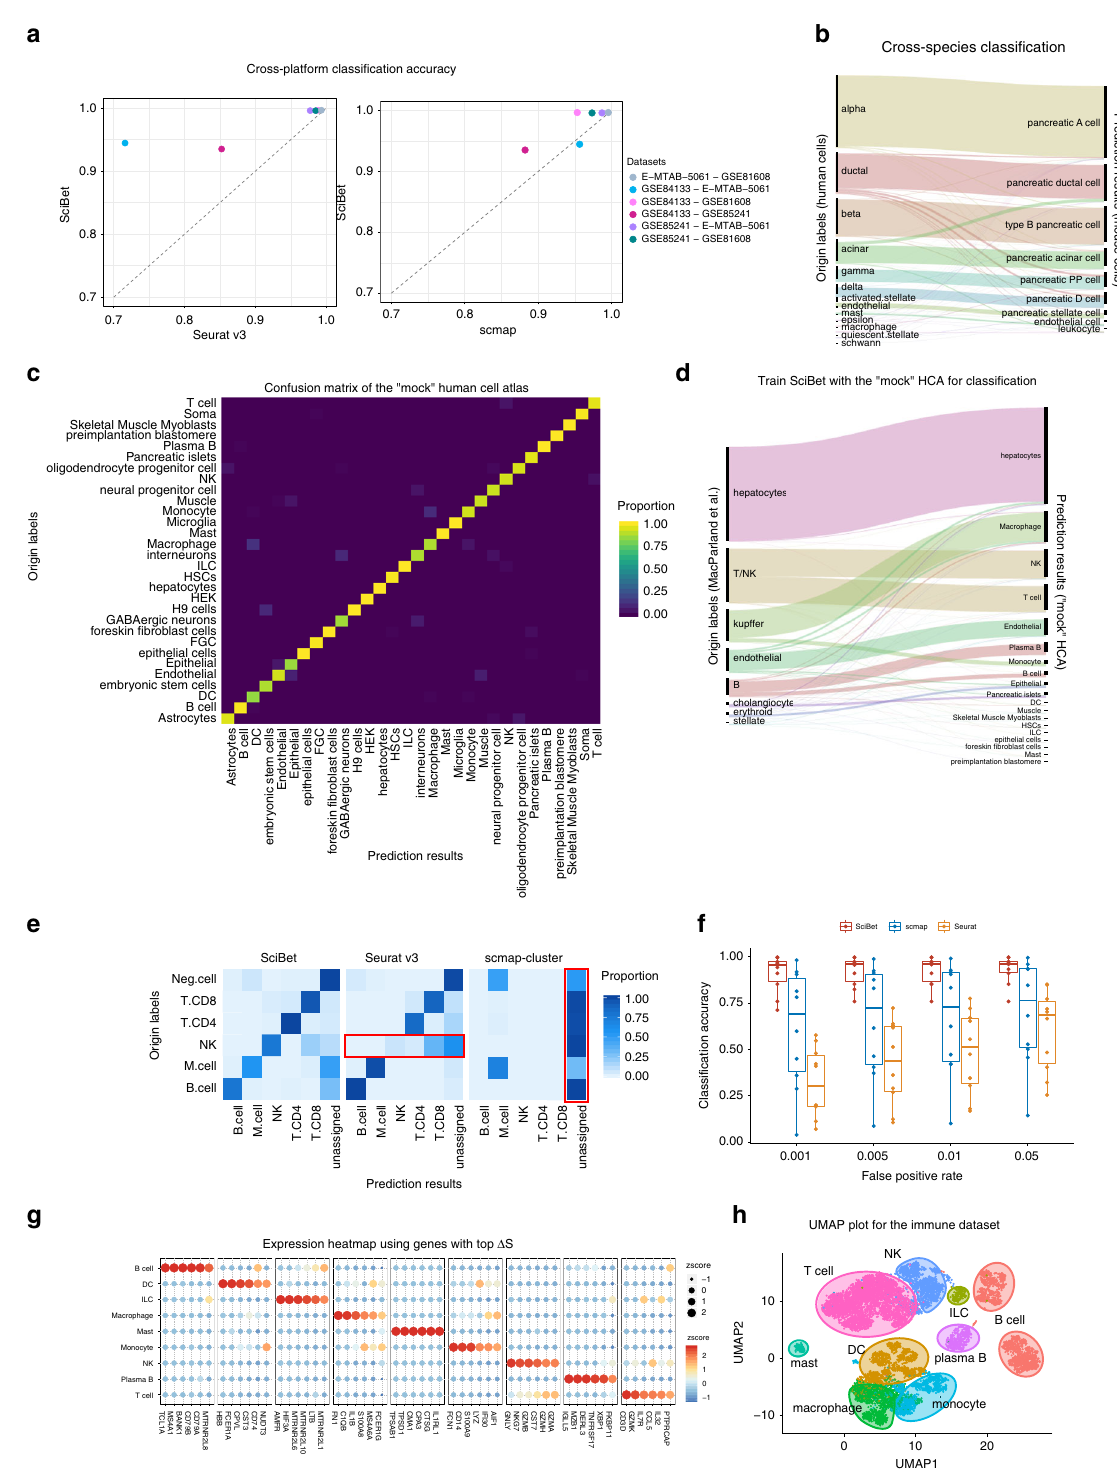
Fig. 3 Applications of SciBet. a Mean accuracy (across 50 repeats) for n = 6 cross-platform dataset pairs listed in Supplementary Table 2. b Cross-species classi fi cation with three human pancreas datasets projected to Tabula Muris dataset (Sankey diagram). The height of each linkage line re fl ects the number of cells. c Confusion matrix of the cross-validation result for 30 cell types in the “ mock ” human cell atlas (listed in Supplementary Table 3). d Single cell classi fi cation for a human liver dataset with integrated human dataset as reference, implemented by SciBet. e Confusion matrix for the case study of false positive control, with normalization for each row (origin label). Negative cells including malignant cells, CAF cells and endothelial cells were removed from the training set. Query cells with lowest classi fi cation con fi dence scores were labeled as unassigned. f False positive control evaluation with cell types not present in reference as negative cells, with n = 10 pairs of datasets (each point represents the mean accuracy score or FPR across 50 repeats). Box plot shows the center line for the median, hinges for the interquartile range and whiskers for 1.5 times the interquartile range. g Expression heatmap of the top 54 genes selected by E- test for the integrated immune dataset (Supplementary Table 6). h 2D-UMAP showing the dimensional reduction result based on the genes in g